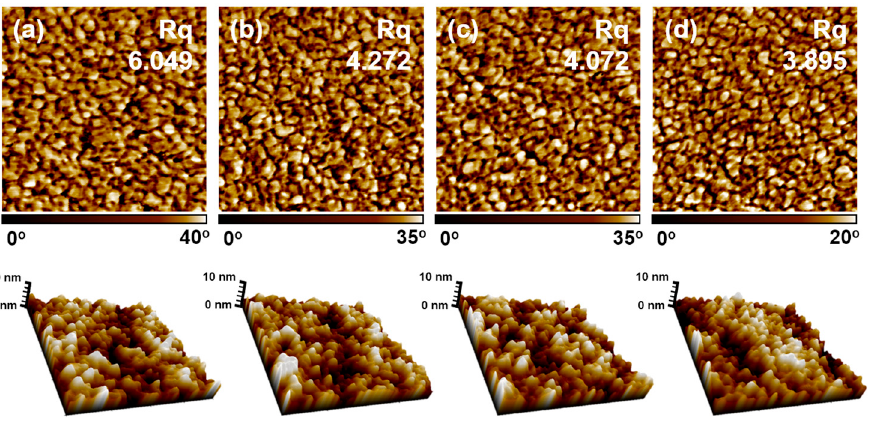
Figure 5. AFM phase images and topographic images of PEDOT:PSS and PEDOT:P(SS- co -VTMS) films with DMSO solution treatment. ( a ) PEDOT:P(SS- co -VTMS) 0 mol %; ( b ) PEDOT:P(SS- co -VTMS) 5 mol %; ( c ) PEDOT:P(SS- co -VTMS) 10 mol %; ( d ) PEDOT:P(SS- co -VTMS) 15 mol %.